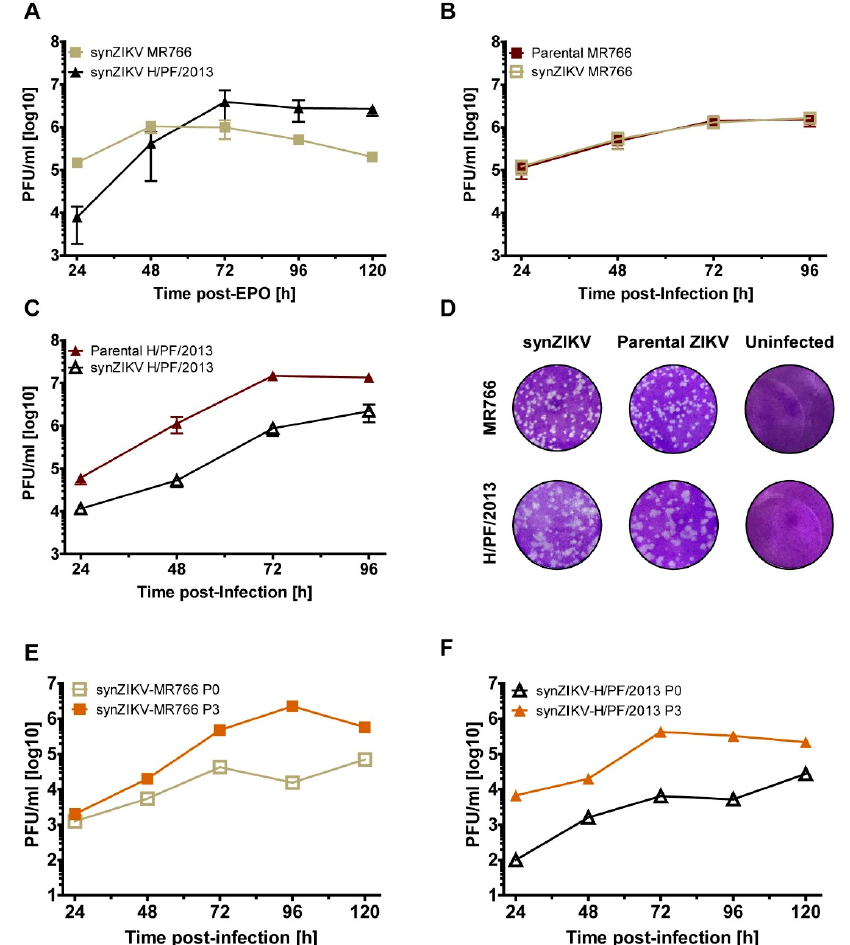
Figure 2. Replication kinetics of viruses obtained with the full-length synZIKV clones. ( A ) Replication kinetics of the two synZIKV clones as determined by plaque assay. VeroE6 cells were transfected with in vitro transcribed synZIKV RNAs and virus contained in culture supernatant at different time points after transfection was measured. Mean ± SEM of two independent experiments is shown. ( B , C ) Comparison of replication kinetics of synZIKV and parental viruses. Huh7 cells were infected with either ZIKV using a multiplicity of infection (MOI) of 1. Supernatants from infected cells were harvested at indicated times post-infection and titres were determined by plaque assay. Mean ± SEM of three independent experiments is shown. ( D ) Comparison of plaque morphology of synZIKV and the parental viruses. ( E , F ) Replication kinetics of passaged synZIKVs. Virus stocks were prepared as described in Materials and methods (P0). Huh7 cells were infected with MOI = 0.1 of P0 virus, cell culture supernatants were collected 72 h post-infection (P1) and passaged two more times by infection of Huh7 cells (P2–P3) in 72 h intervals. Huh7 cells were then infected using a MOI of 0.01 of P0 and P3 virus, respectively and virus titres were measured at indicated time points by plaque